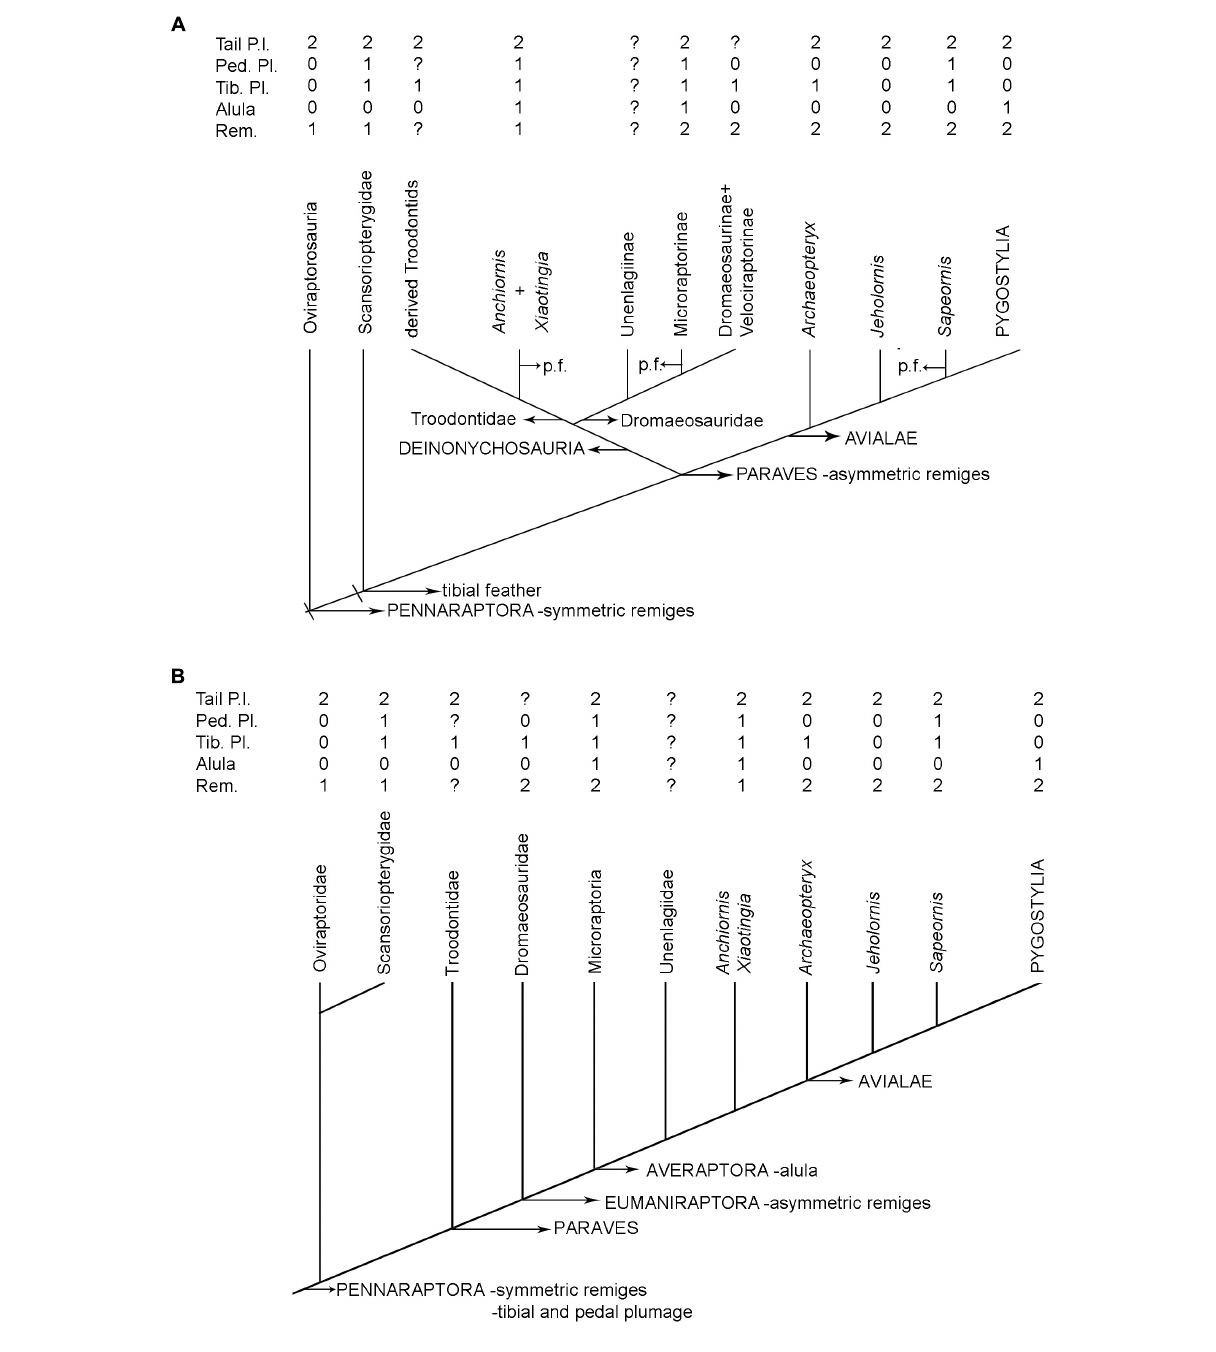
FIGURE 11 | Simplified cladograms showing the distribution of feathers among derived coelurosaurs following the proposals of: (A) Gianechini et al. (2017); and (B) Agnolin and Novas (2013). Tail Pl., tail plumage; Ped. Pl., pedal or metatarsal plumage; Tib. Pl., tibial plumage; Rem., forelimb remiges; ?, uncertain condition; 0, absence; 1, presence of plumulaceous feathers; 2, presence of pennaceous